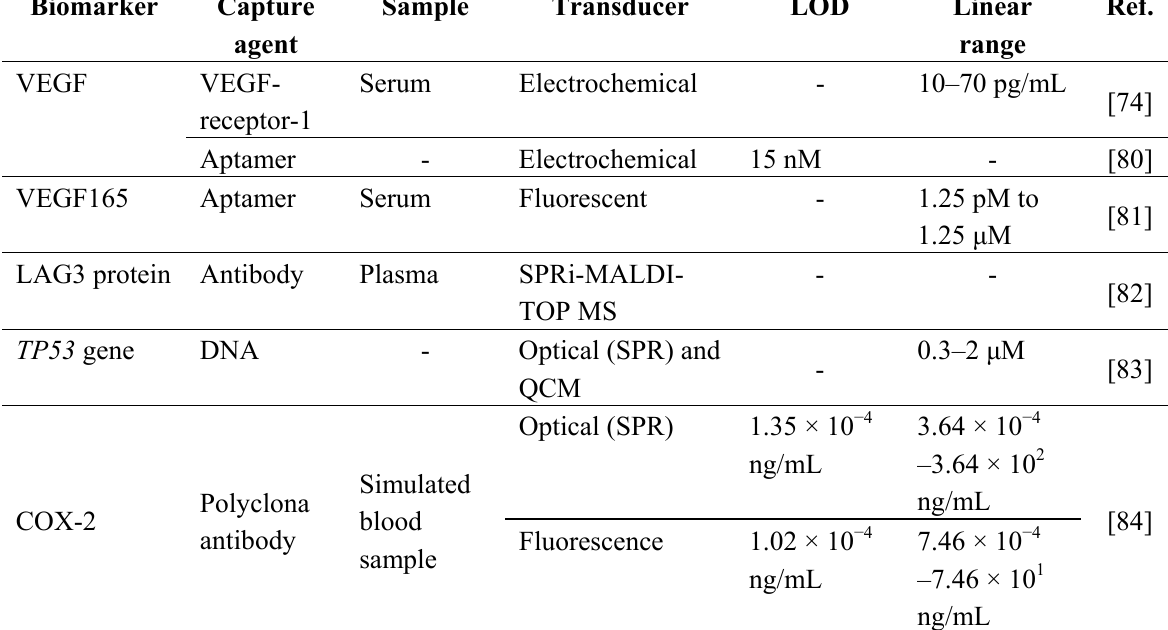
Table 2. The limit of detection (LOD) and linear range of the lung cancer biomarker detection